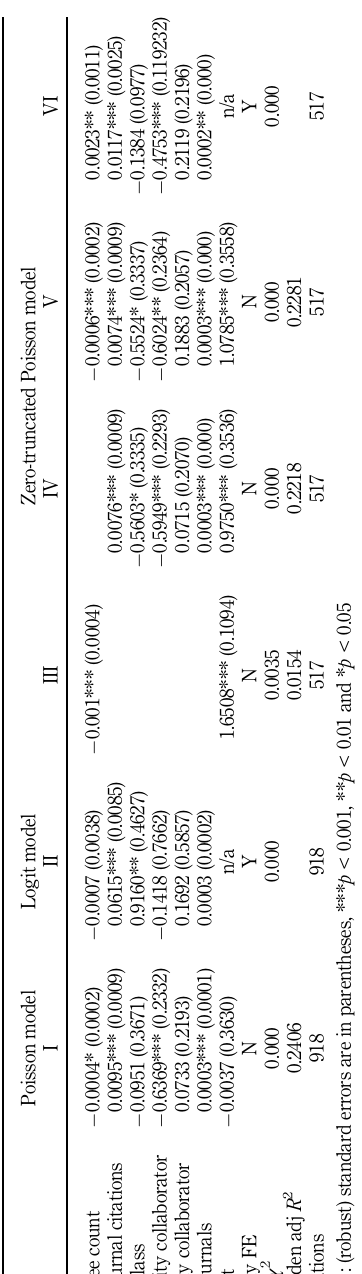
Table 4. The negative coefficient of variables using Poisson logit and zero-truncated Poisson